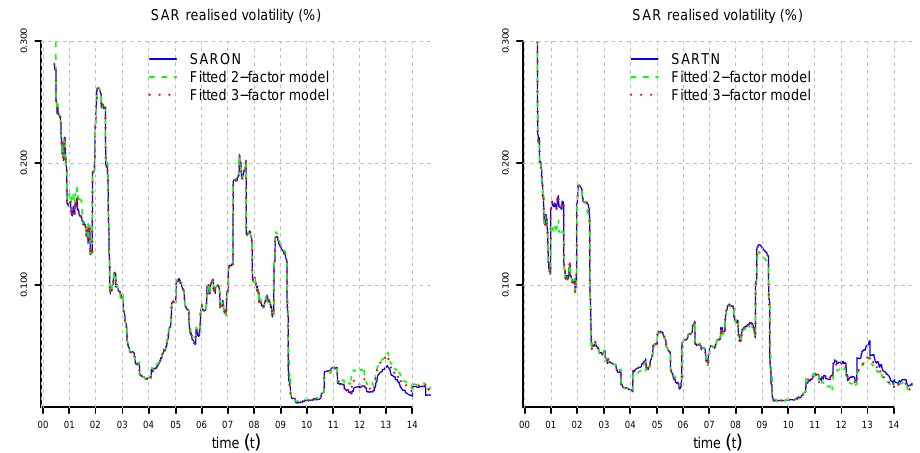
(cid:92) Figure 8. SAR realized volatility RCov ( t , τ , τ ) 1 2 for K = 126, τ = 1 (lhs), τ = 2 (rhs) and all observation dates compared to the realized volatility of the two- and three-factor Vasiˇcek models fitted by optimization (23) for M = 6, τ 1 = 1, τ 2 = 2, τ 3 = 5, τ 4 = 10, τ 5 = 21, τ 6 = 63 and w ij = 1 { i = j }